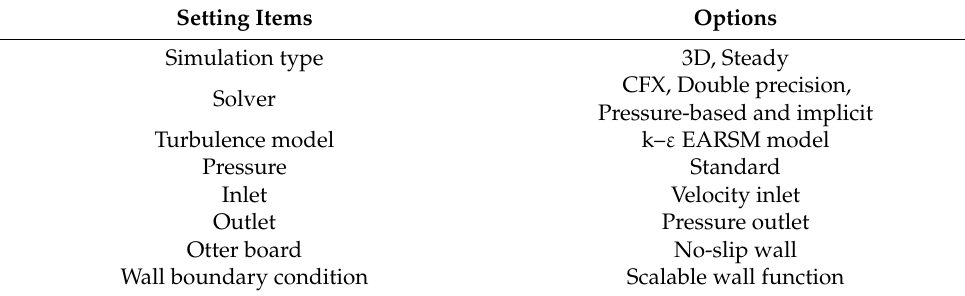
Figure 5. Boundary conditions of the computational domain. Table 4. Parameter settings of the numerical